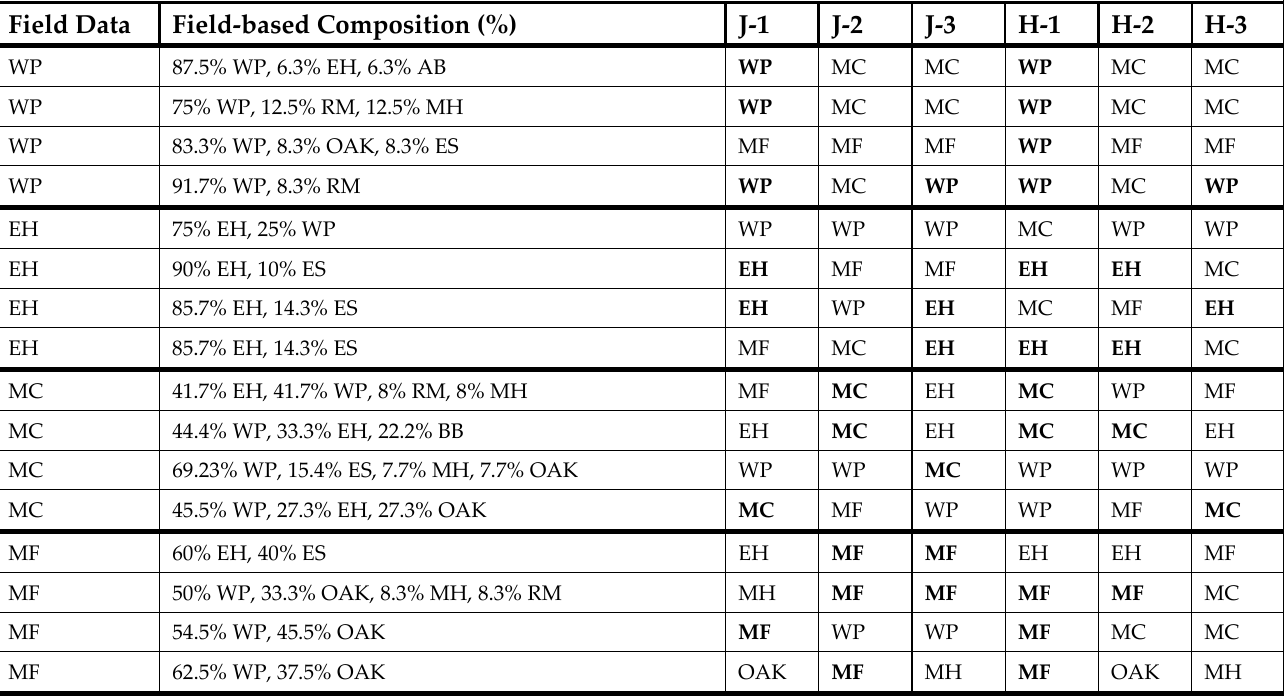
Table 4. Unmanned aerial system (UAS) qualitative assessment of visual interpretation uncertainty for individual forest inventory plots of varying species composition (nine classes) across six trials. Note: the green box indicates agreement with the field data, while the red box indicates disagreement. The two visual interpreters are referenced as ‘J’ and ‘H’ with their three trials labeled each as ‘1’, ‘2’, and ‘3’. Composition classes found within this table include white pine (WP), eastern hemlock (EH), mixed conifer (MC), mixed forest (MF), oak mixtures (OAK), American beech (AB), red maple (RM), mixed hardwoods (MH), and early successional (ES).